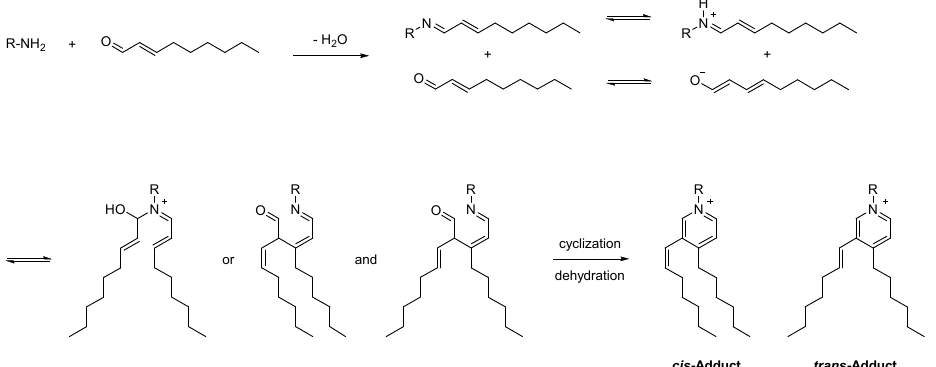
Figure 4. Proposed reaction mechanism leading to formation of pyridinium derivatives from amine- containing compounds in the presence of trans -2-nonenal.